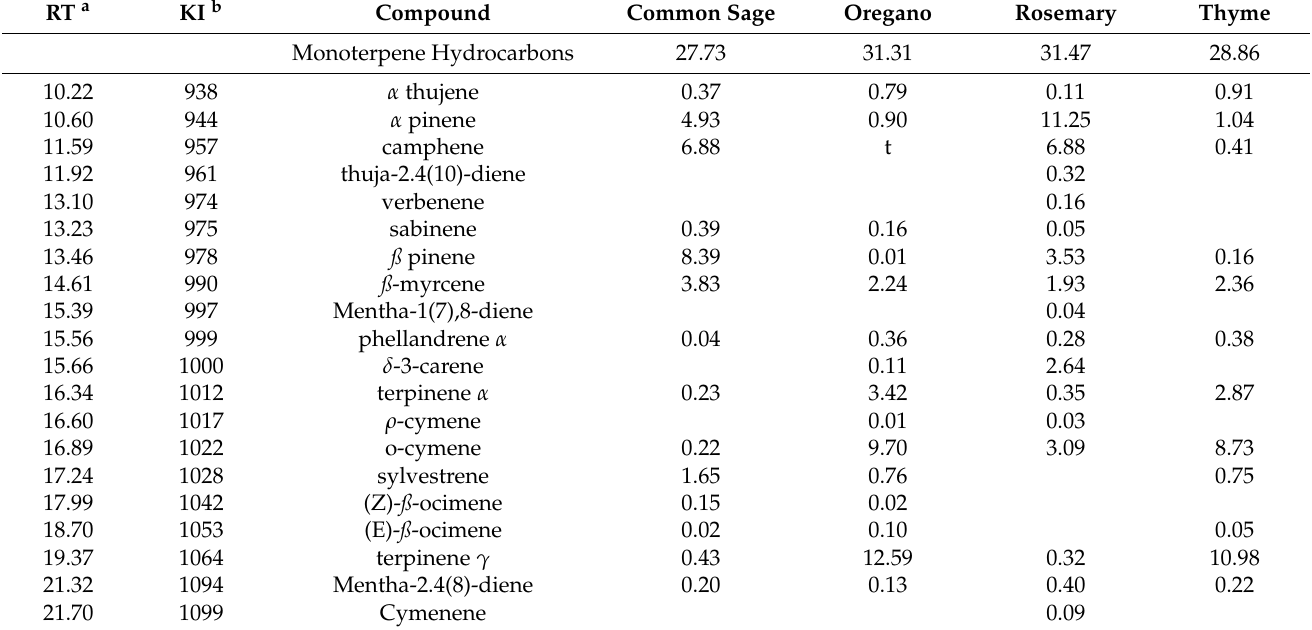
Table 3. Chemical composition of EOs of the common sage, oregano, rosemary and thyme